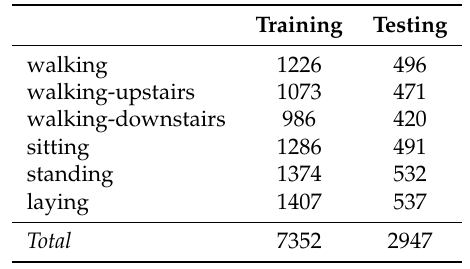
Figure 3. Example of four human activities: walking, walking-upstairs, and walking-downstairs. Table 1. Activities distribution over the training and testing sets in UCI HAR database.